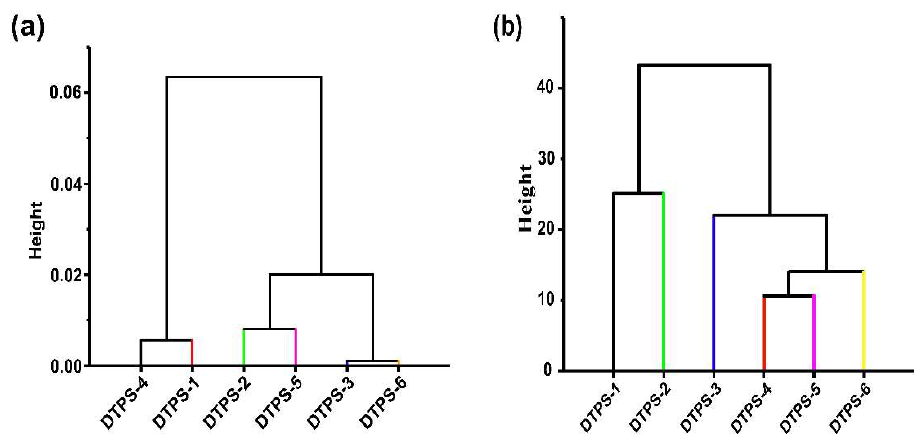
Figure 7. Cluster dendrogram of antioxidant ( a ) and hypoglycemic ( b ) capabilities. Table 4. Glycosidase inhibition and free radical scavenging activities (IC50) of the DTPSs. Sample